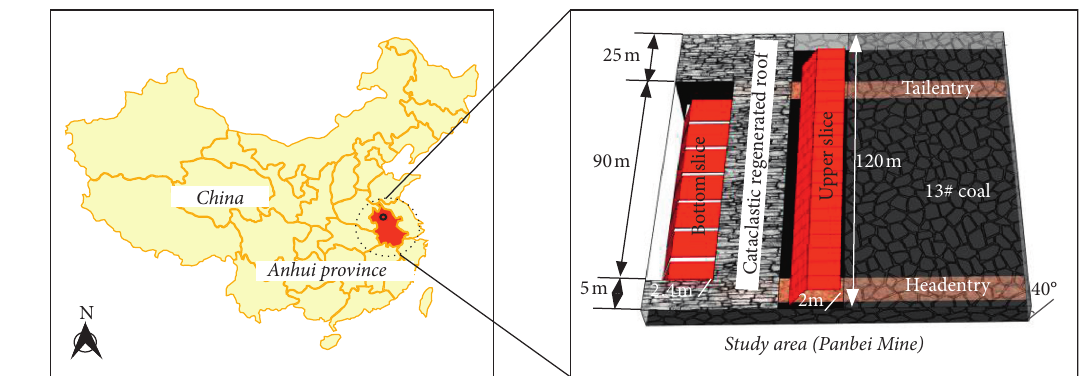
Figure 2: The location and production conditions of 12123 working Table 1: Rock physical and mechanical parameters and similarity ratios.